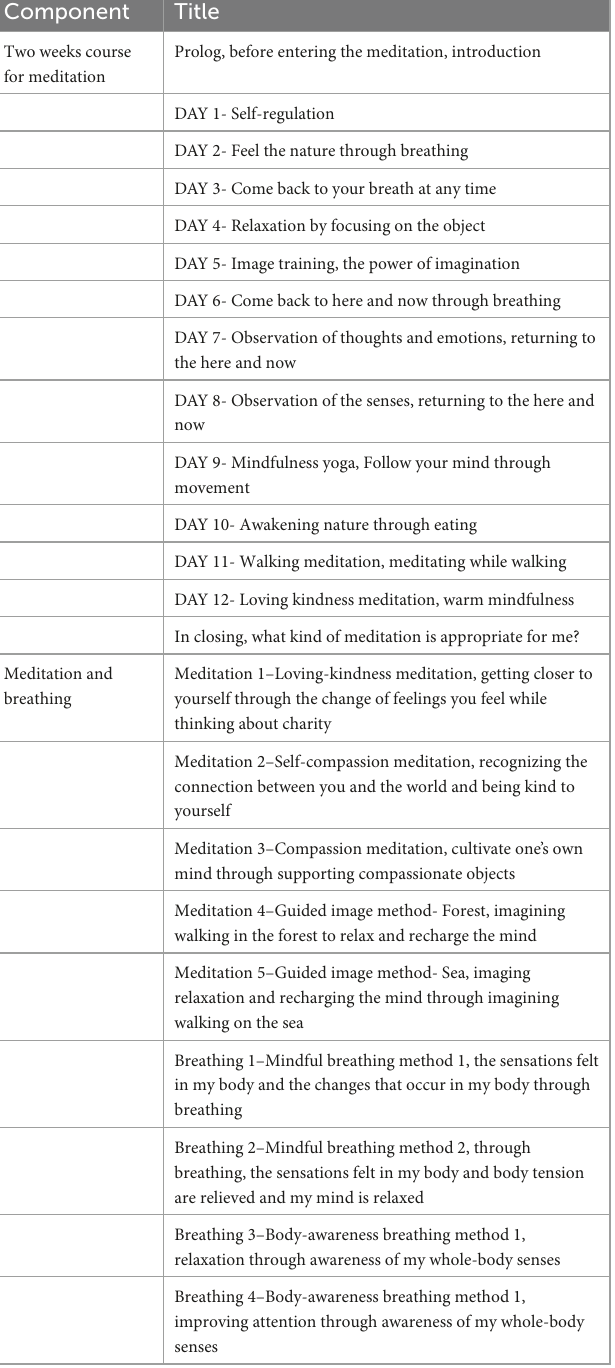
TABLE 1 Titles and contents of the meditation module.